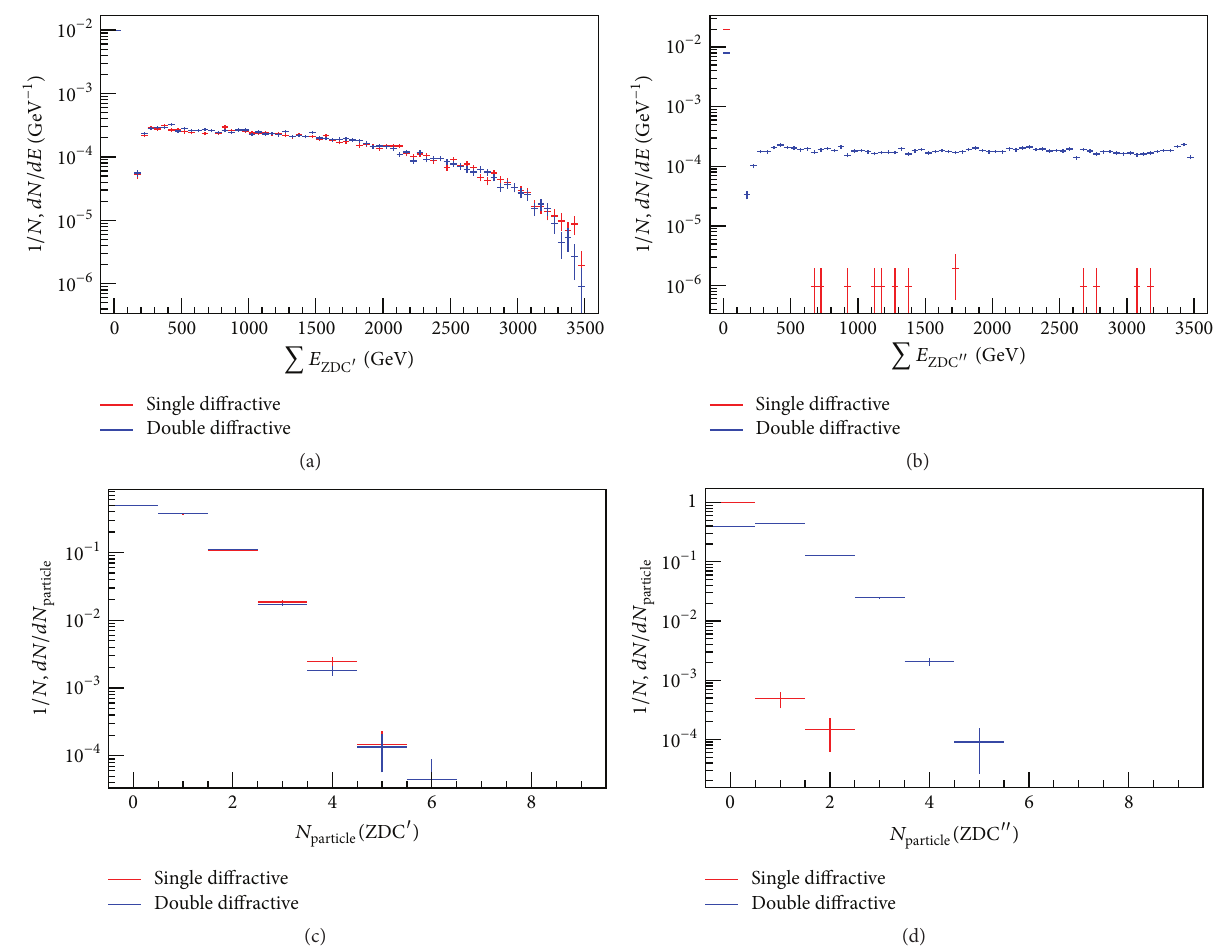
Figure 12: The total energy deposition and the multiplicity of the neutral particles with 𝑝 0 T > 100 MeV in the ZDC detectors for the events that have an edge gap in |𝜂| < 5.2 with a gap size Δ𝜂 > 3 , and with 𝐸 ̸= 0 in the opposite side from the gap (either at 𝜂 < 0 or 𝜂 > 0 depending on the gap position). A cut of 𝑝 T > 200 MeV was applied for the final state particles in |𝜂| < 5.2 to find the size of the gap. ZDC 󸀠 refers to the ZDC which is on the side opposite to the gap and ZDC 󸀠󸀠 is the ZDC on the side with the gap. Total energy deposition in (a) ZDC 󸀠 and (b) ZDC 󸀠󸀠 and particle multiplicity in (c) ZDC 󸀠 and (d) ZDC 󸀠󸀠 are given. The distributions are normalized to the number of events, N , that pass the analysis cuts.